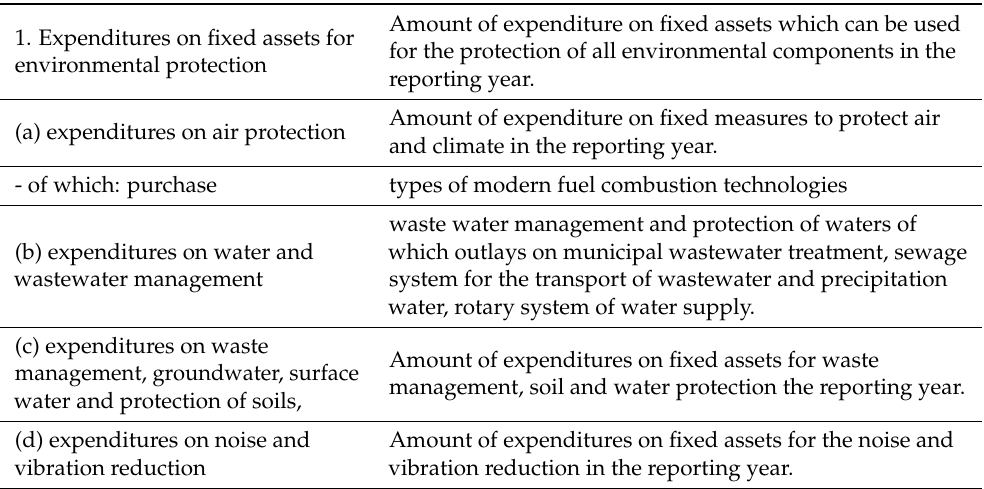
Table 3. Typology of expenditures on environmental fixed assets in the Polish industrial statistical